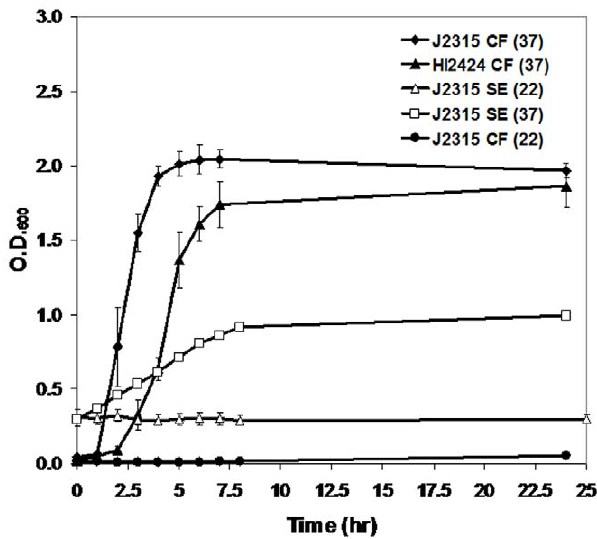
Figure 1. Experimental conditions. Growth, measured by O.D. 600 , of strains J2315 and HI2424 under the following conditions: Black diamonds, triangles, circles, and squares represent strain J2315 grown in CF at 37 u C, SE at 22 u C, CF at 22 u C, and SE at 37 u C, respectively. Open triangles represent strain HI2424 grown in CF medium at 37 u C. Error bars represent a single standard deviation of the data.